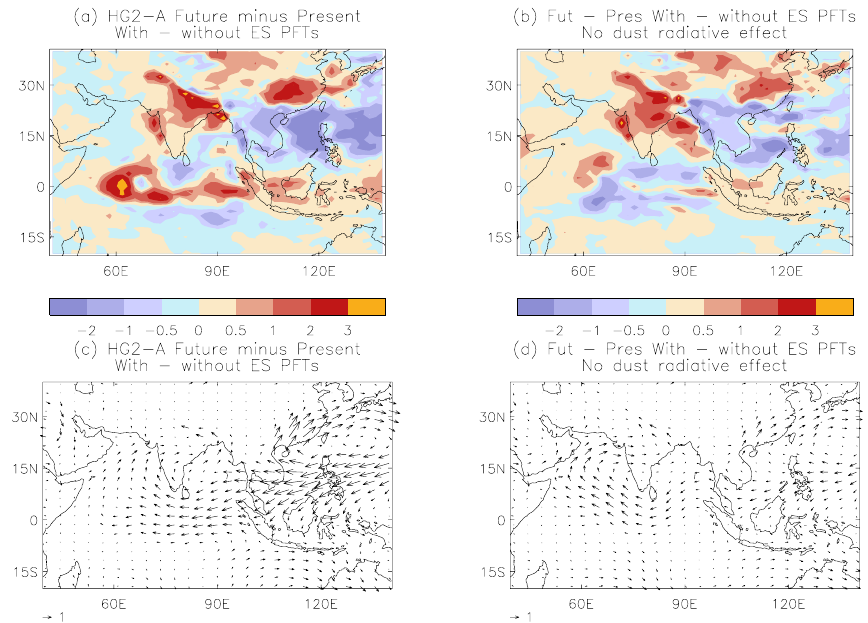
Fig. 14. Difference in the projected future-present changes in seasonal mean rainfall and horizontal wind at 850hPa between runs with and without land cover taken from HadGEM-ES RCP8.5 experiments: (a) and (c) with, and (b) and (d) without direct radiative effects of dust.